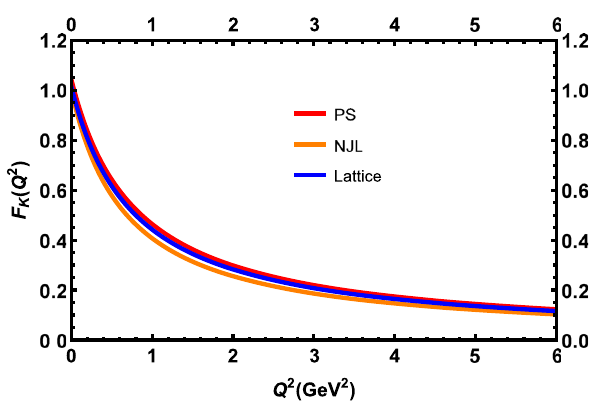
Fig. 7 Comparison of the kaon electromagnetic form factor with dif- ferent studies (orange solid line [29] and blue solid line [30])